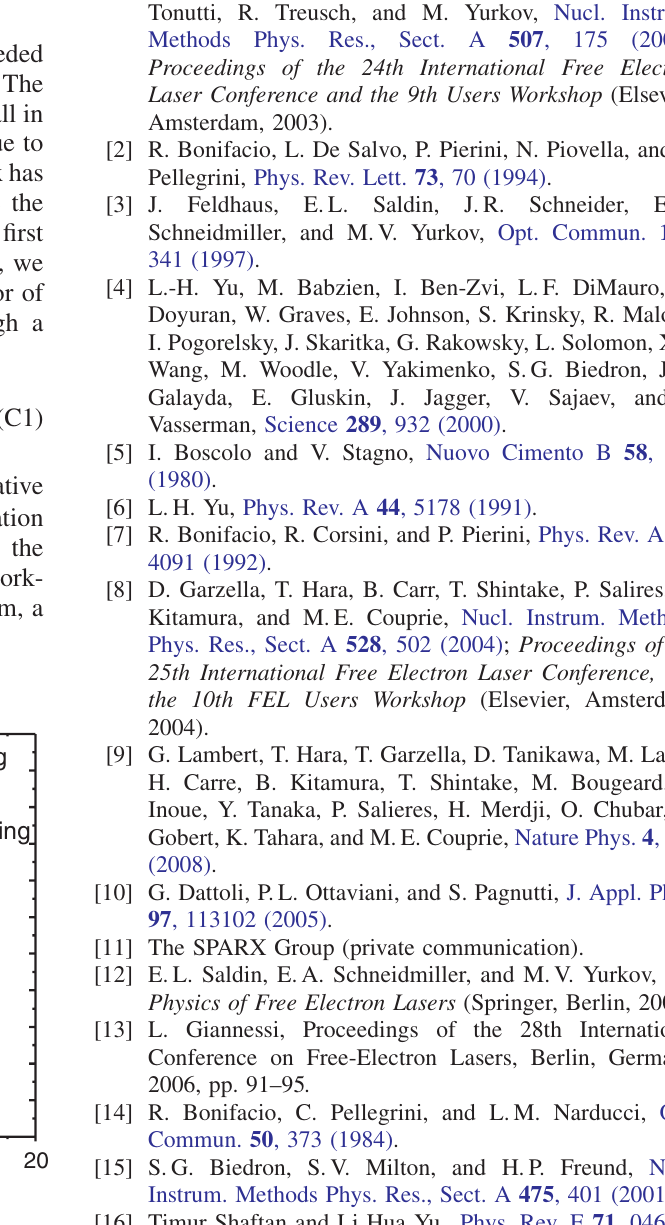
FIG. 15. Magnetic chicane layout and optical